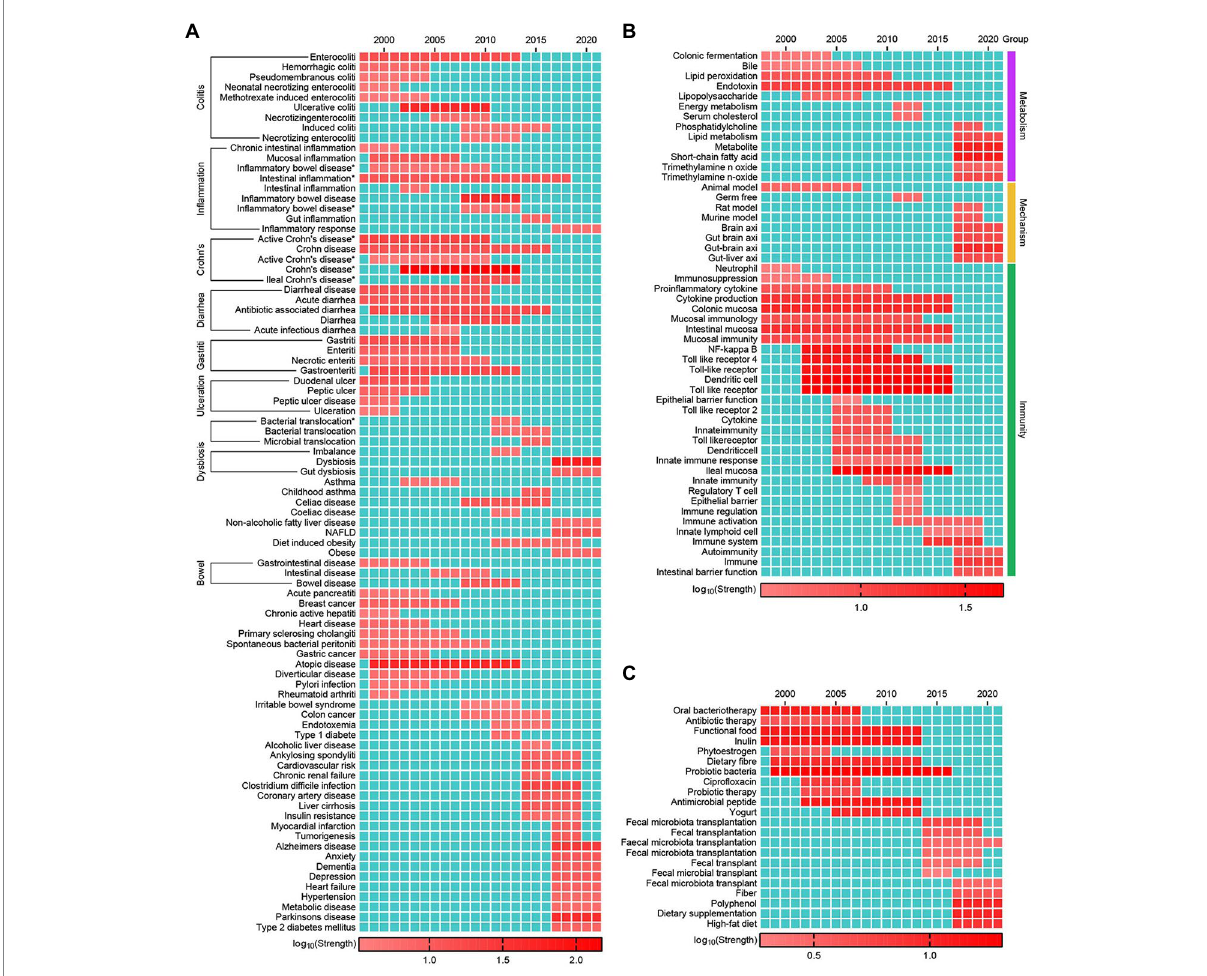
FIGURE 3 Keywords with strongest bursts from 1998 to 2021. (A) The keywords related to “Diseases/Conditions.” (B) The keywords related to “Immunity,” “Mechanism,” and “Metabolism.” (C) The keywords related to “Intervention.” Asterisk (*) indicate the origin words missed single quotation marks or blank and has been corrected. The red bars indicate burst duration and